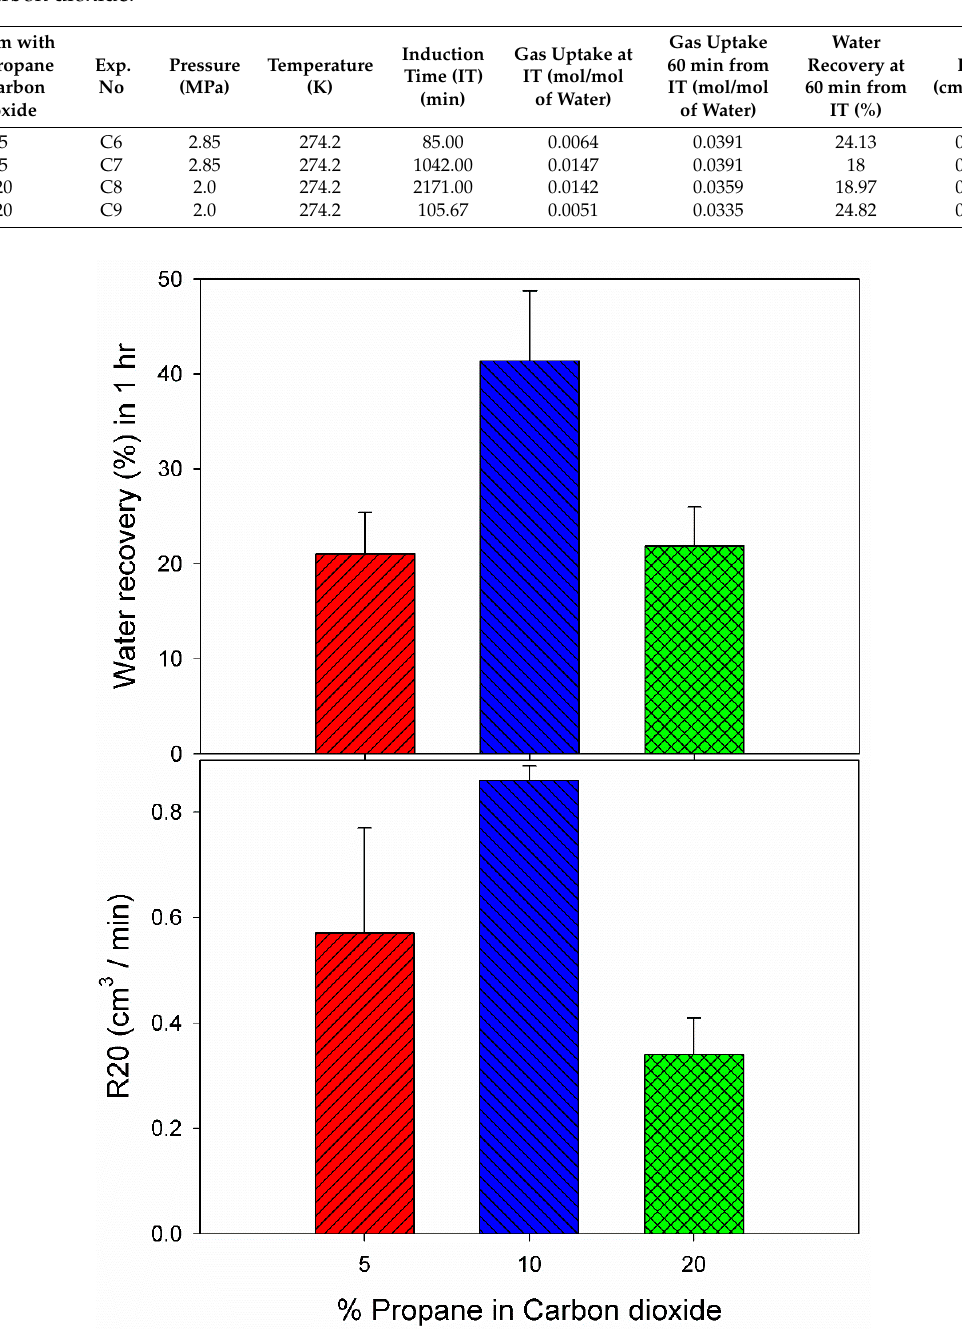
Figure 10. Effect of propane composition in carbon dioxide with 3.0 wt% NaCl aqueous